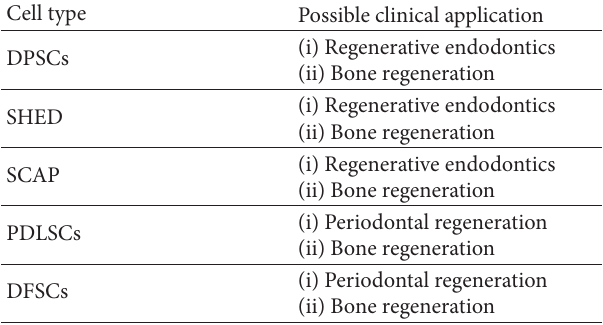
Table 2: The possible clinical application fields of dental stem cells and tissue